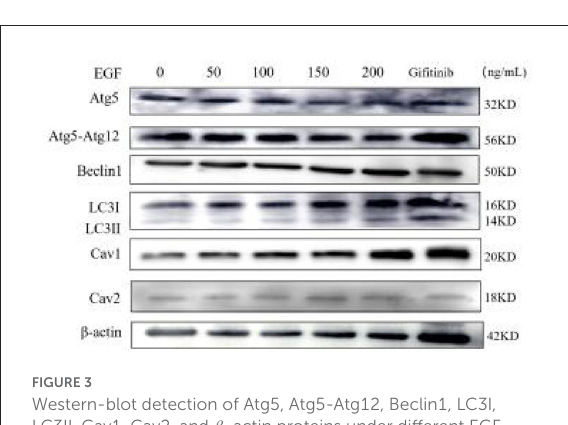
FIGURE3 Western-blot detection of Atg5, Atg5-Atg12, Beclin1, LC3I, LC3II, Cav1, Cav2, and β -actin proteins under different EGF concentrations and EGFR inhibitor action group. From left to right: 0, 50, 100, 150, 200ng/mL EGF group and EGFR inhibitor gefitinib group.